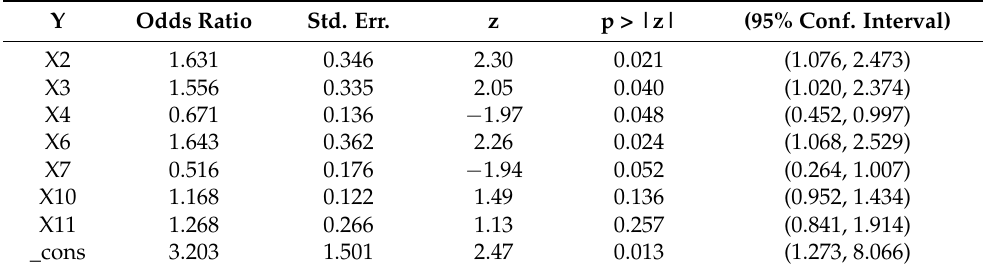
Table A7. The sixth step of stepwise logistic regression.